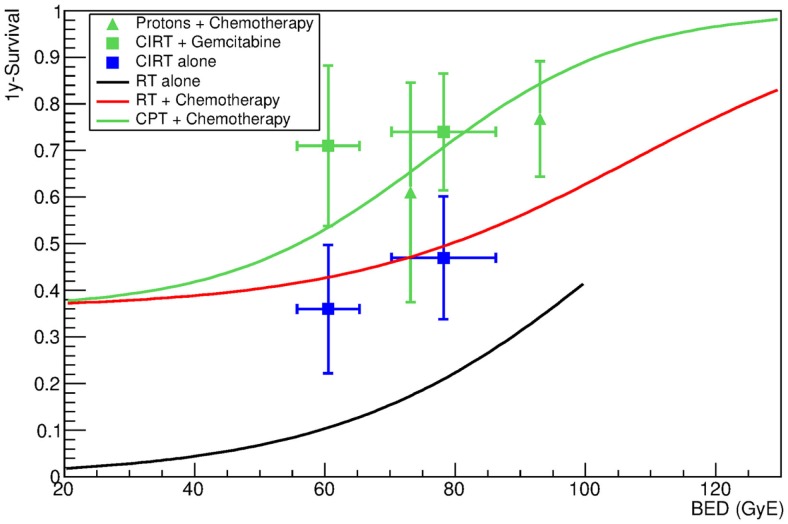
One-year survival as a function of the BED for patients undergoing CPT with or without additional chemotherapy. Blue symbols refer to patients receiving radiotherapy with C-ions without additional chemotherapy. Green symbols refer to data obtained with proton (triangles) and carbon ions (full squares) in combination with chemotherapy. Data are given in Table 6. The green line shows the result of the fit of data for chemotherapy combined with proton or carbon ions. The fit was performed using γ50 and CS from X-ray + chemotherapy data. The only free parameter is therefore D50. The black and red lines show the results of the fit for X-rays alone and X-rays plus chemotherapy, and are reported for comparison. Fitting parameters are in Table 3.